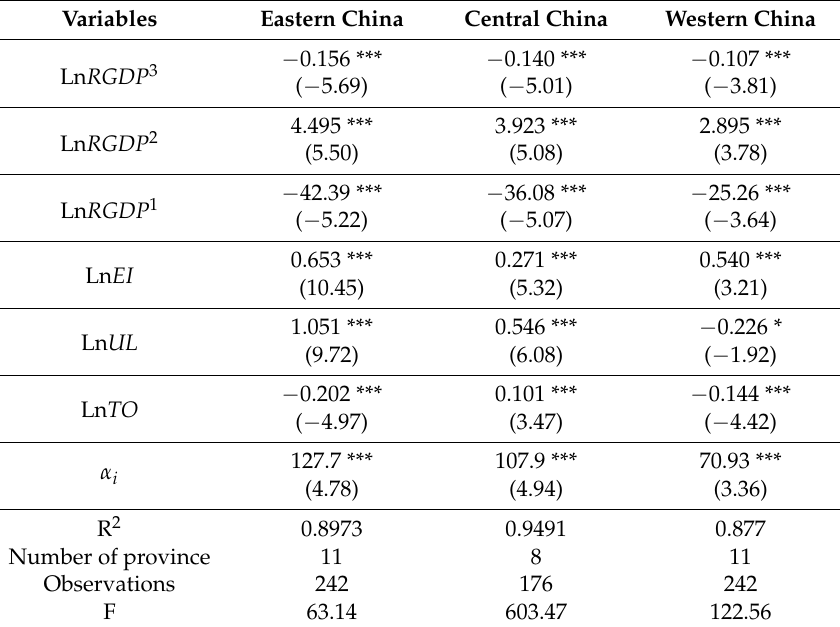
Table 3. Panel EKC-estimated results in three regions.